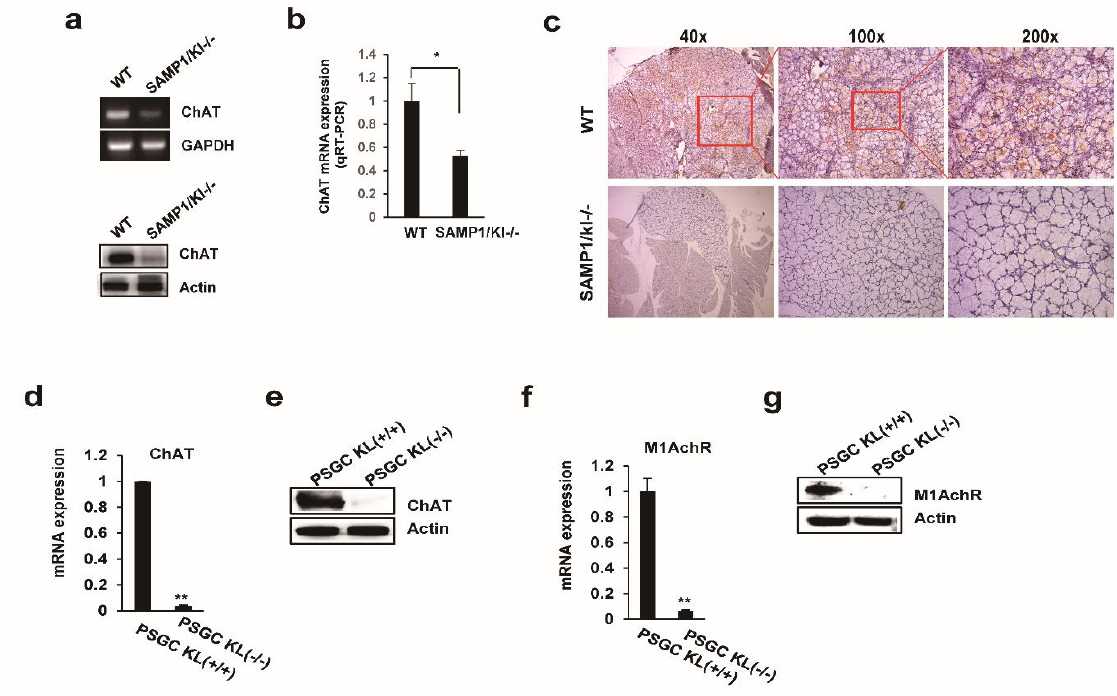
Figure 3. Downregulation of choline acetyltransferase (ChAT) in the Klotho-deficient model. ( a , b ) Comparison of ChAT expression in the salivary gland tissues of SAMP1/kl +/+ and SAMP1 kl -/- mice. Total RNA and total protein were extracted from the salivary gland tissues of SAMP1/kl +/+ and SAMP1 kl -/- mice, and ChAT expression was measured by RT-PCR, qRT-PCR, and Western blotting. ( c ) Immunohistochemistry staining of ChAT in 4 μ m sections of salivary gland tissues from SAMP1/kl +/+ and SAMP1 kl -/- mice. ( d - g ) Comparison of cholinergic signaling related gene expression in primary salivary gland cells (PSGC) kl +/+ and PSGC kl -/- cell lines. Data are presented as the mean ± SD. * p < 0.05, ** p < 0.01.